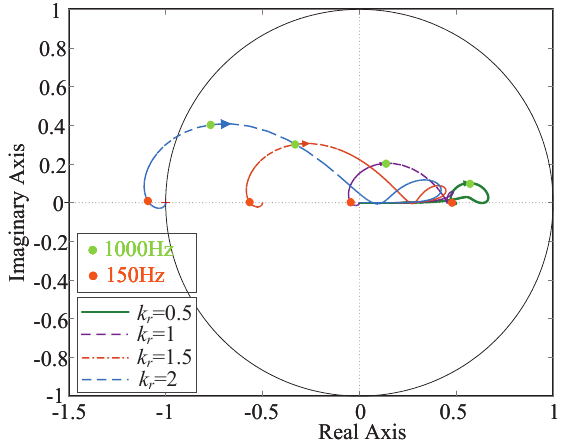
Figure 7. The trajectory of H ( e j ω T m ) when k r takes different values.